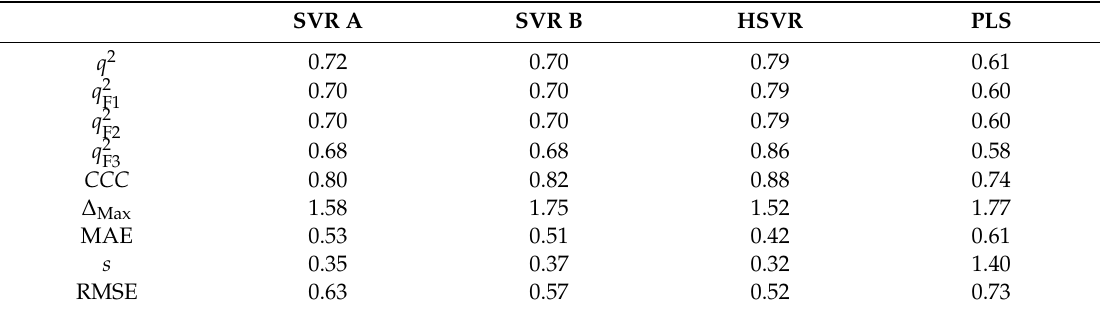
, q 2 , and q 2 , concordance correlation F1 F2 F3